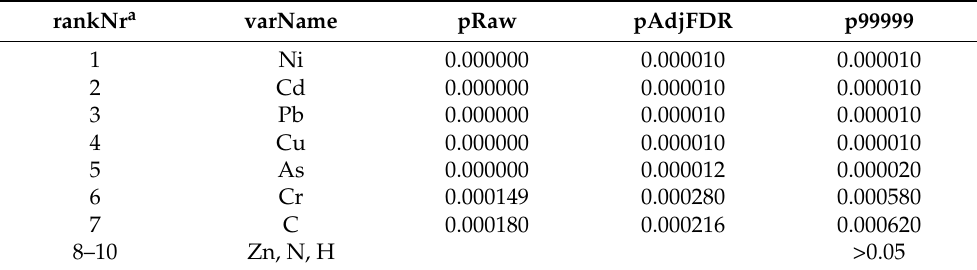
Table 7. Rank of the variables analyzed by rotation simulations test (for each biomass n ◦ = 30). aRankNr: rank of the variables analyzed; pRaw: ordinary univariate p -values; pAdjFDR: adjusted p -values according to false discovery rates; p99999: adjusted p -values according to the familywise error rate. rankNr a